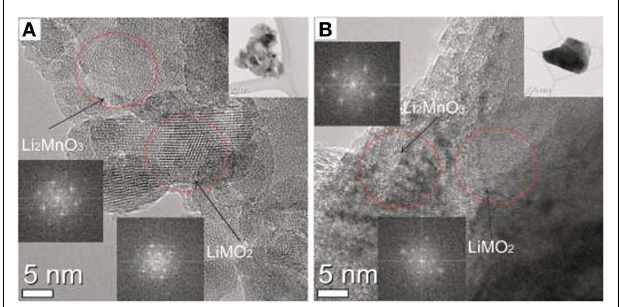
FIGURE 2 | HRTEM images: (A) 0.5Li 2 MnO 3 · 0.5LiMO 2 (B) heat treated 0.5Li 2 MnO 3 · 0.5LiMO 2 . Reproduced with permission of Kim et al.